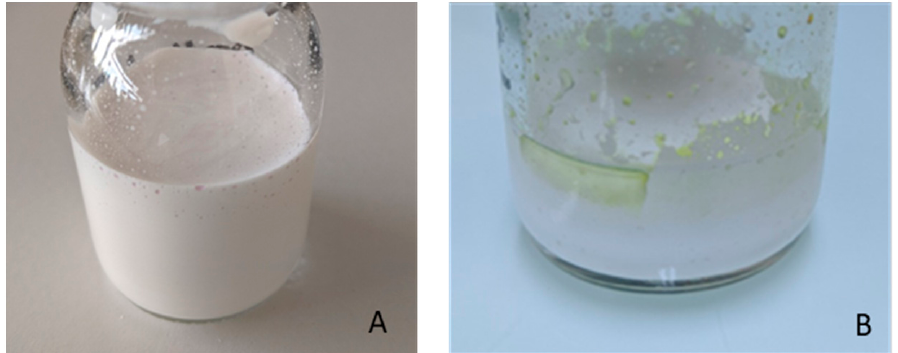
Figure 1. NE of propofol after extemporaneous addition to Intralipid ® 20%. ( A ) Immediately after the addition and ( B ) a few days later.